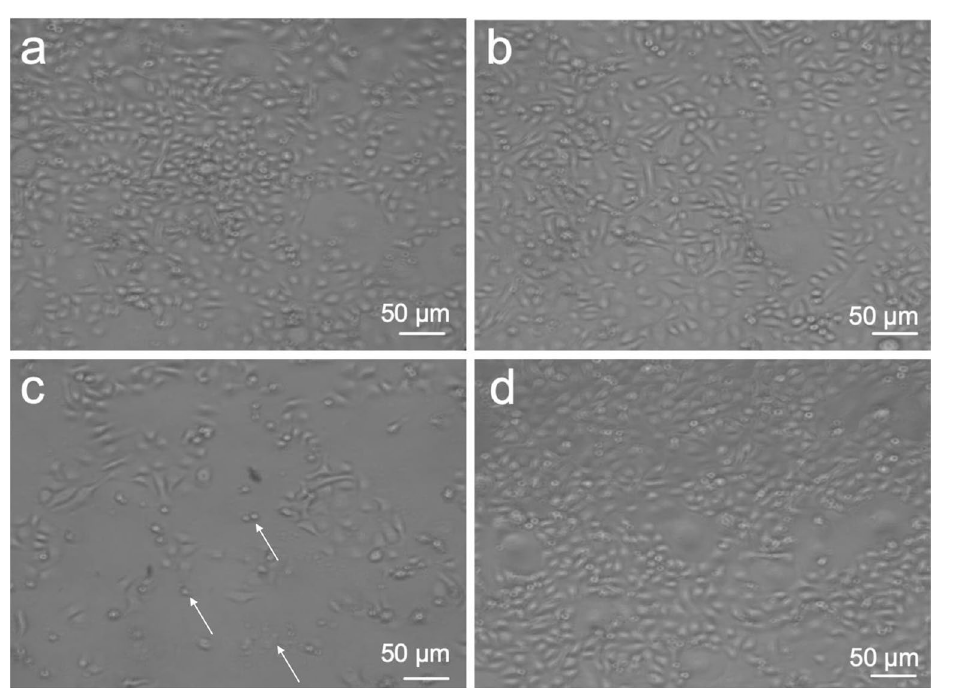
Figure 3. Light microscopic analysis of HGK after incubation with 72 h eluates of PP ( a ), BE ( b ), and ME ( c ) for 72 h in comparison to the non-treated control ( d ). HGK undergoing apoptosis are shown exemplarily using